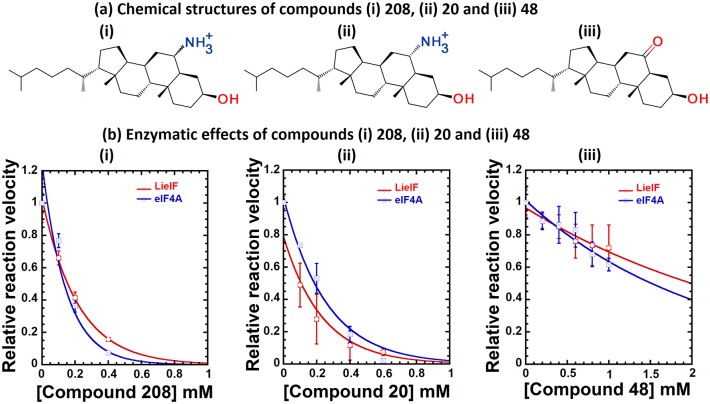
Relative reaction rates of the two proteins in the presence of increasing concentrations of compounds 208, 20 and 48.(a) Chemical structures of the three analogous compounds identified as inhibitors of LieIF. (b) Points with error bars on each curve represent the mean and standard deviations of three independent measurements made using the compound concentrations in the 0 to 1 mM range. The relative reaction velocities were normalized to 1 in the absence of inhibitor to facilitate comparisons. Data were fit to an exponential decay. The relative reaction rate of LieIF (in red) and eIF4AIMus (in blue) in the presence of increasing concentrations of the compounds were plotted as a function of compound concentrations. The compounds clearly presented different kinetic properties according to the proteins.